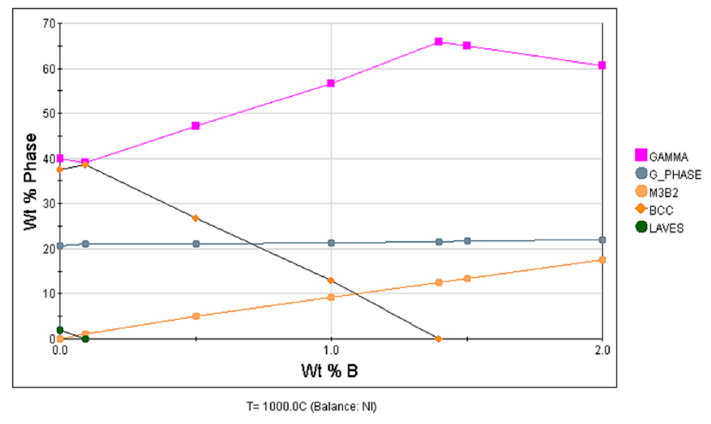
Figure 1. Effect of different content of B element on phase separation of austenitic surfacing.